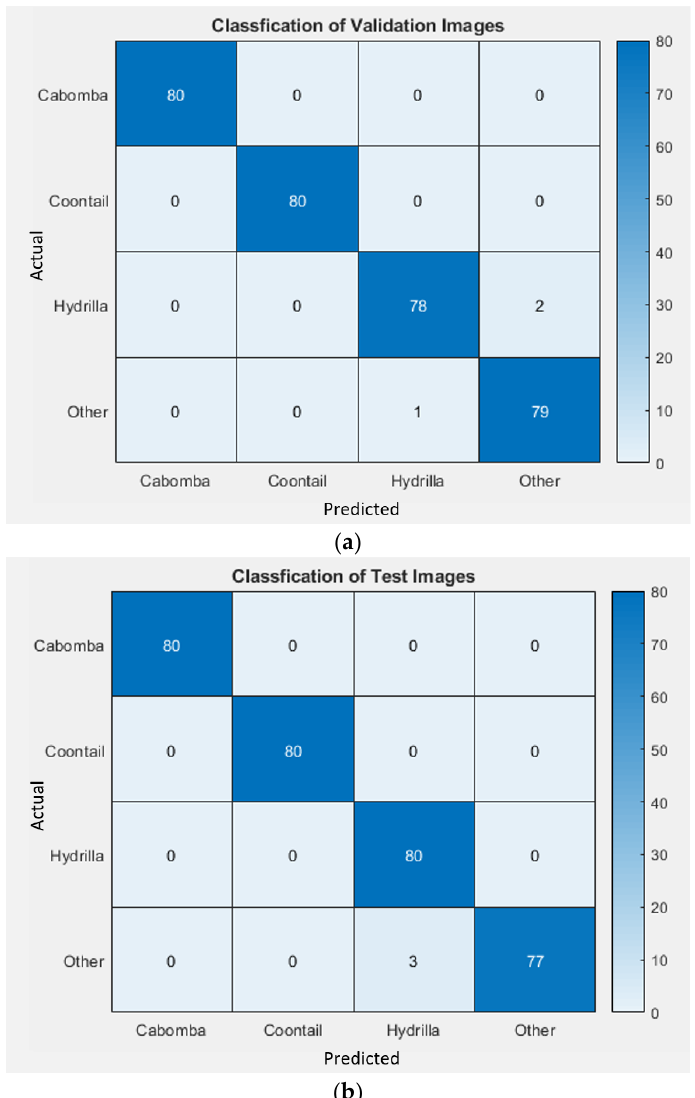
Figure 20. Confusion matrices of classified vegetation species for ( a ) validation and ( b ) test images.